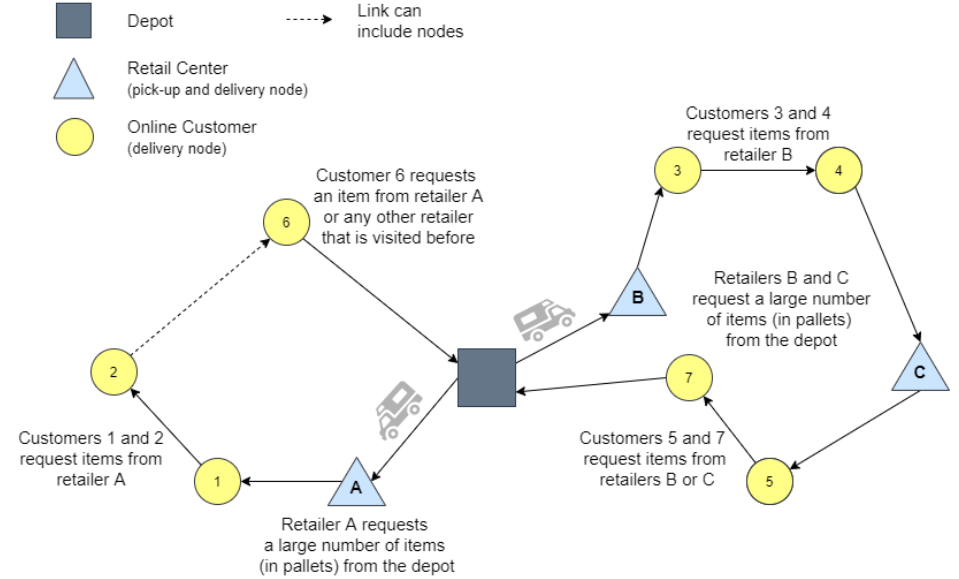
Figure 1. A general schema of the